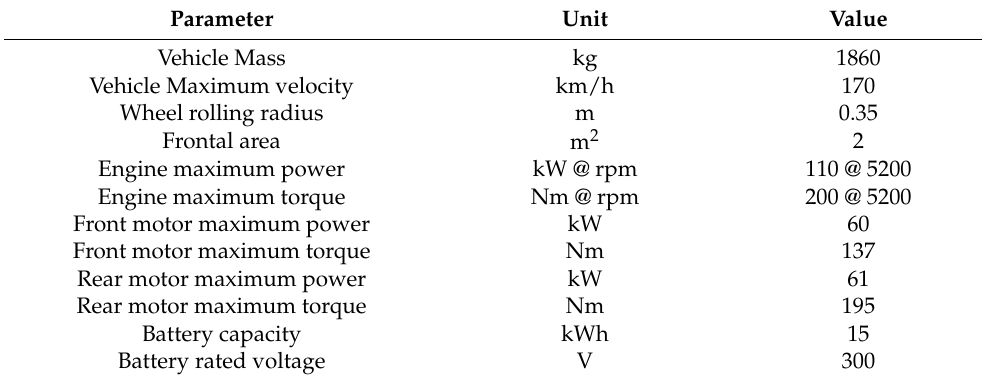
Table 2. Vehicle and dynamic components parameters in the 4DW PHEV.